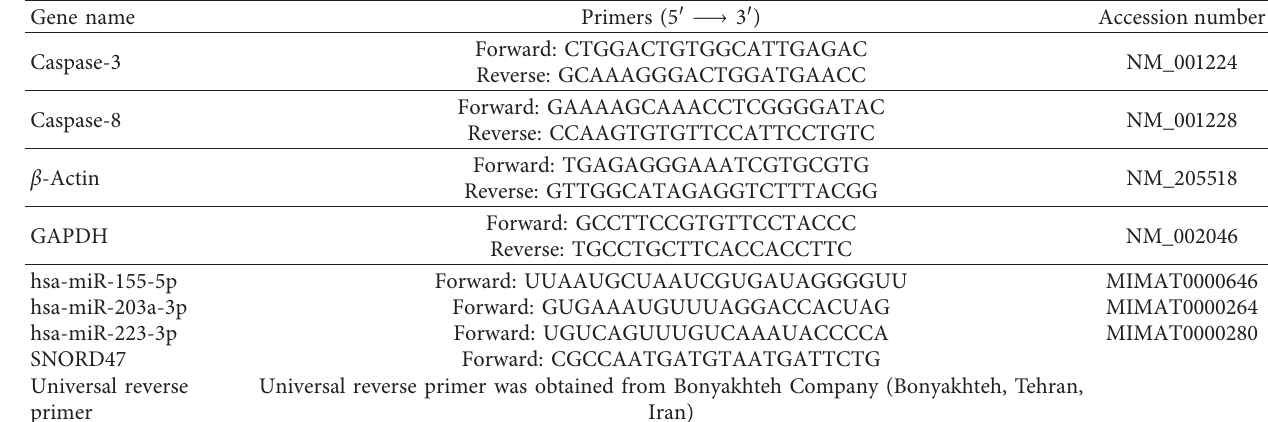
Table 1: The sequences of forward and reverse designed primers for target